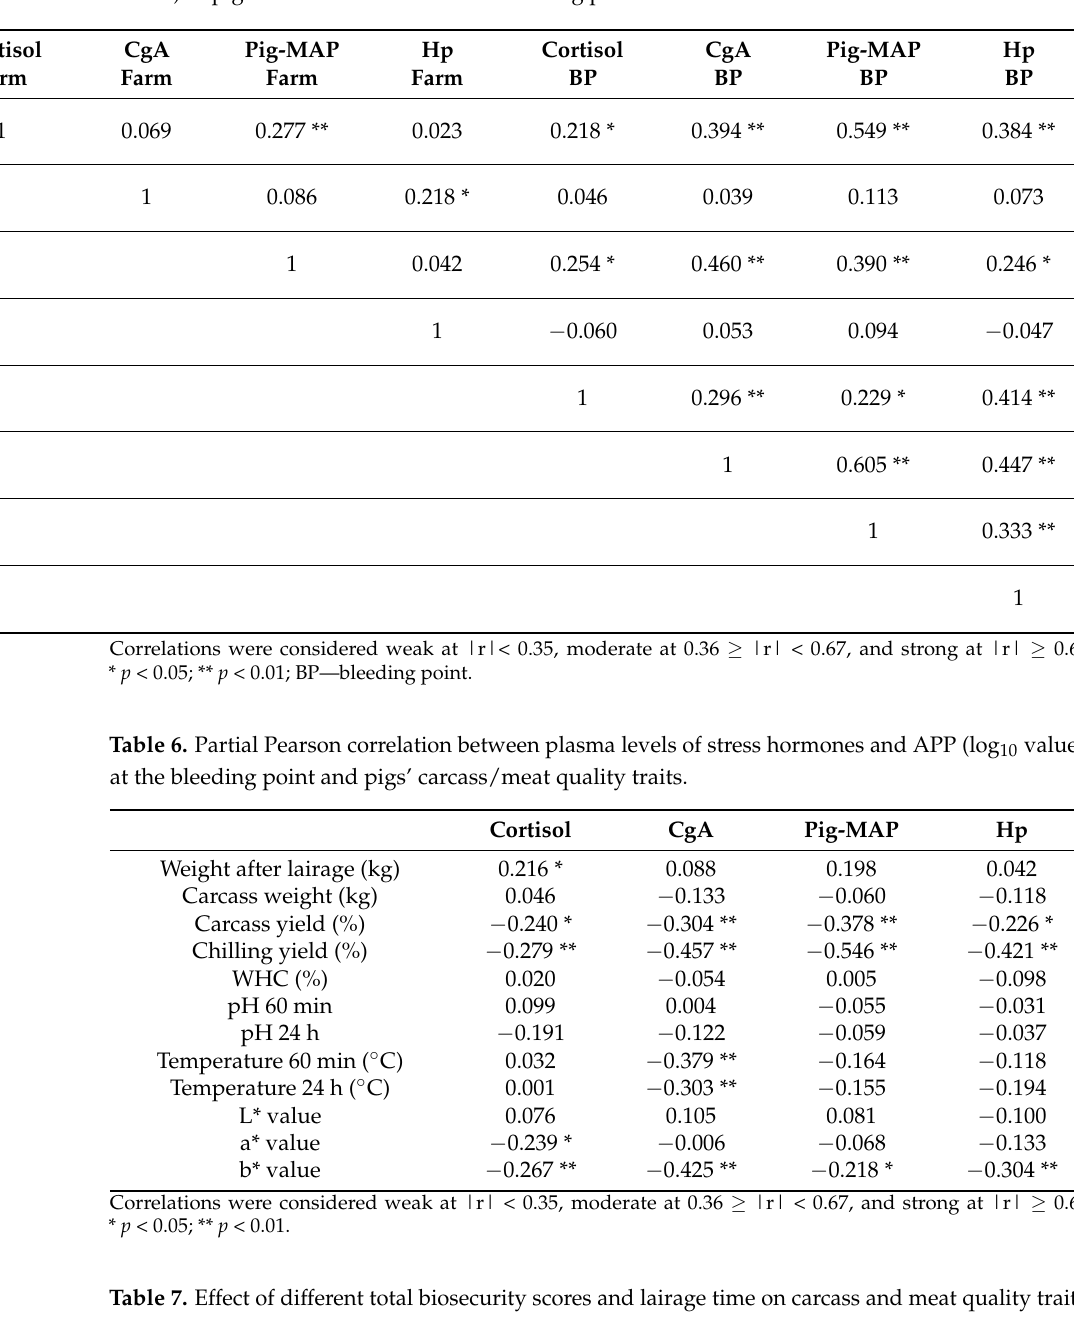
Table 5. Partial Pearson correlation among stress and acute-phase proteins plasma levels (log 10 values) in pigs at four farms and at the bleeding point.